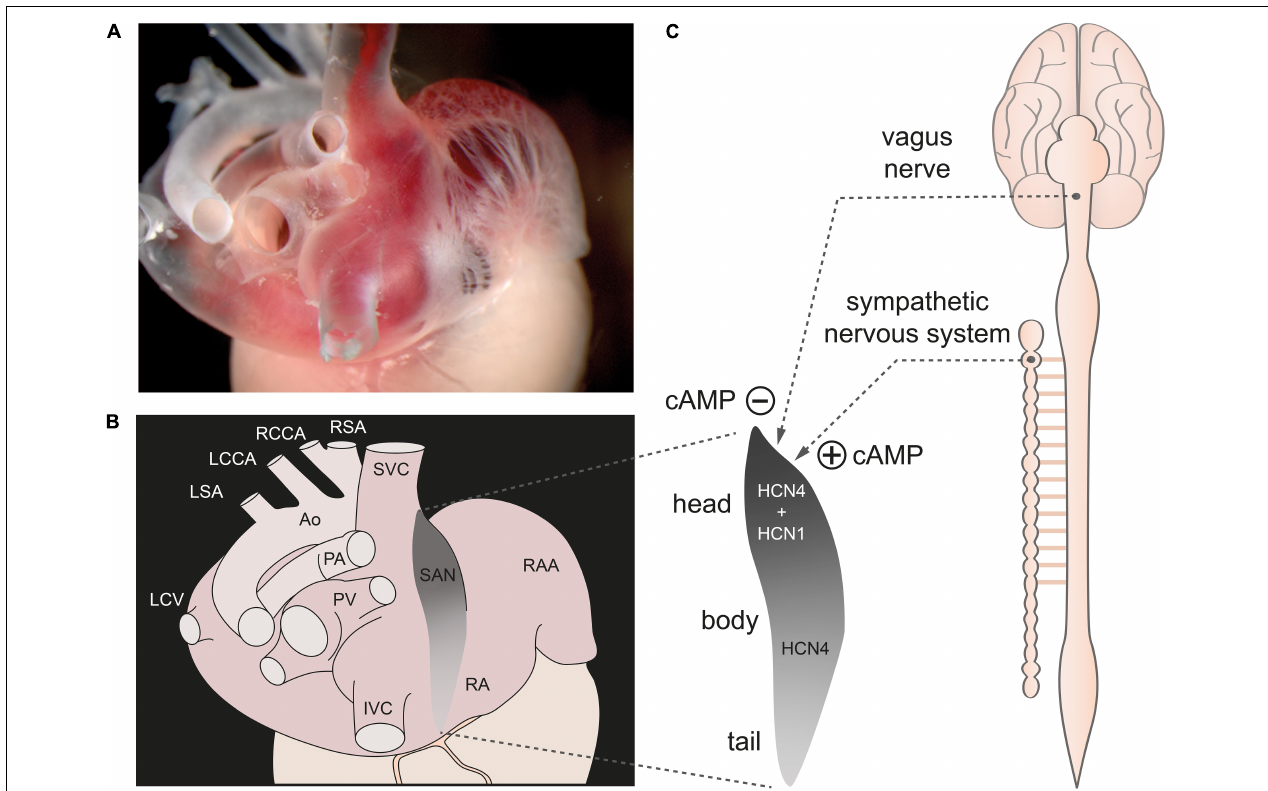
FIGURE 1 | The sinoatrial node. (A) Dorsolateral view of the sinoatrial node region of a gelatine-filled mouse heart. (B) Schematic illustration of the heart shown in panel (A) , depicting the location of the sinoatrial node (SAN) (gray) within the right atrium (RA). (C, left ) Magnification of the SAN region. The cranial portion is referred to as the sinus node “head,” the middle portion as the “body,” and the caudal portion as the “tail.” HCN1 channels are only expressed in the head region whereas HCN4 channels are expressed throughout the whole SAN. (C, right) The SAN is innervated by the sympathetic and parasympathetic nervous system (dashed lines). Activity of both ANS branches tightly controls cAMP concentration in SAN cells. Abbreviations: Ao, Aorta; IVC, inferior vena cava; LCCA, left common carotid artery; LCV, left cranial vein; LSA; left subclavian artery; PA, pulmonary arteries; PV, pulmonary veins; RAA, right atrial appendage; RCCA, right common carotid artery; RSA, right subclavian artery; SVC, superior vena cava. Figure is adapted from Hennis et al., 2021.